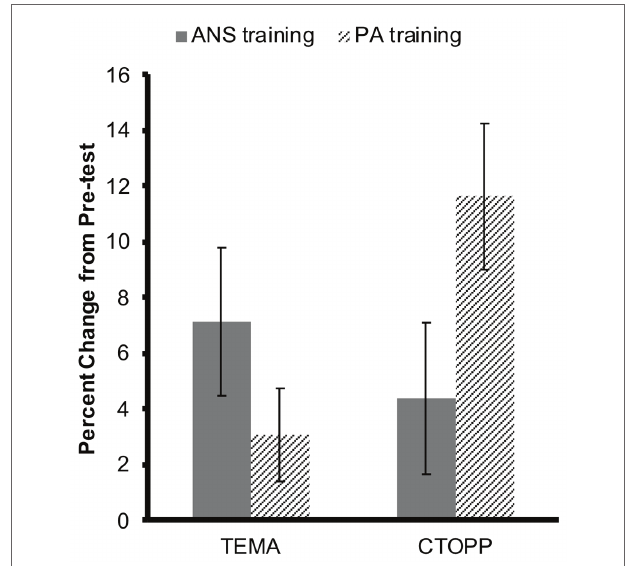
FIGURE 5 | Percent change from pre-training performance on the TEMA and the Comprehensive Test of Phonological Processing (CTOPP) for children in the ANS and PA training groups, respectively. Error bars depict standard errors of the